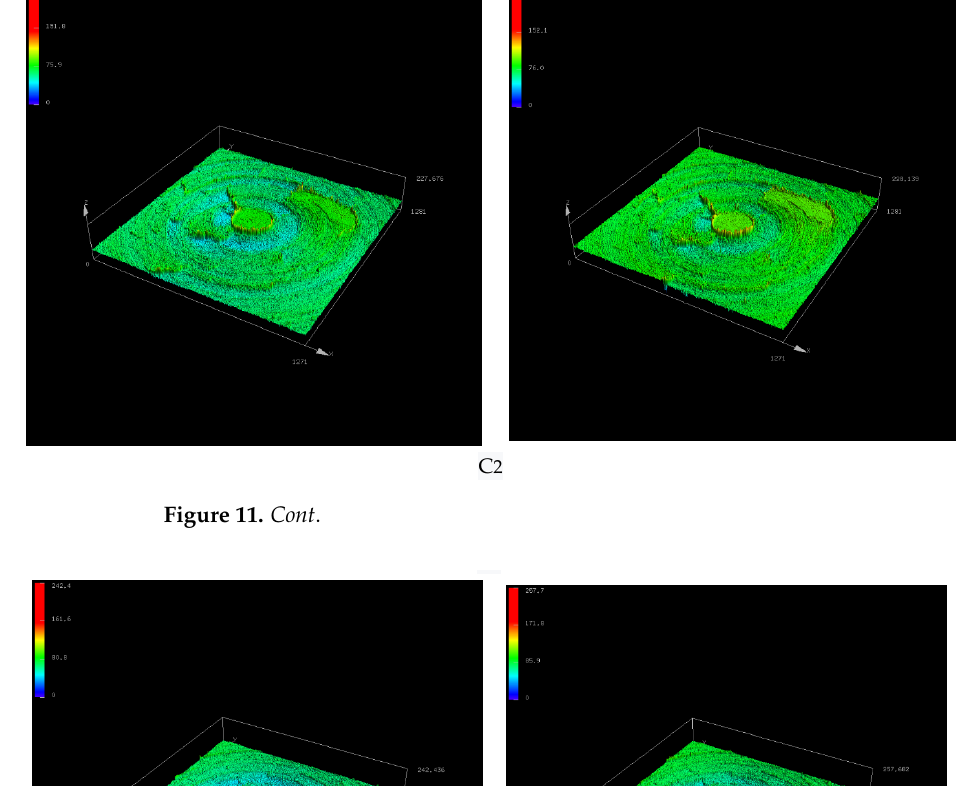
Polymers 2022 , 14 , x FOR PEER REVIEW Figure 11. Cont .